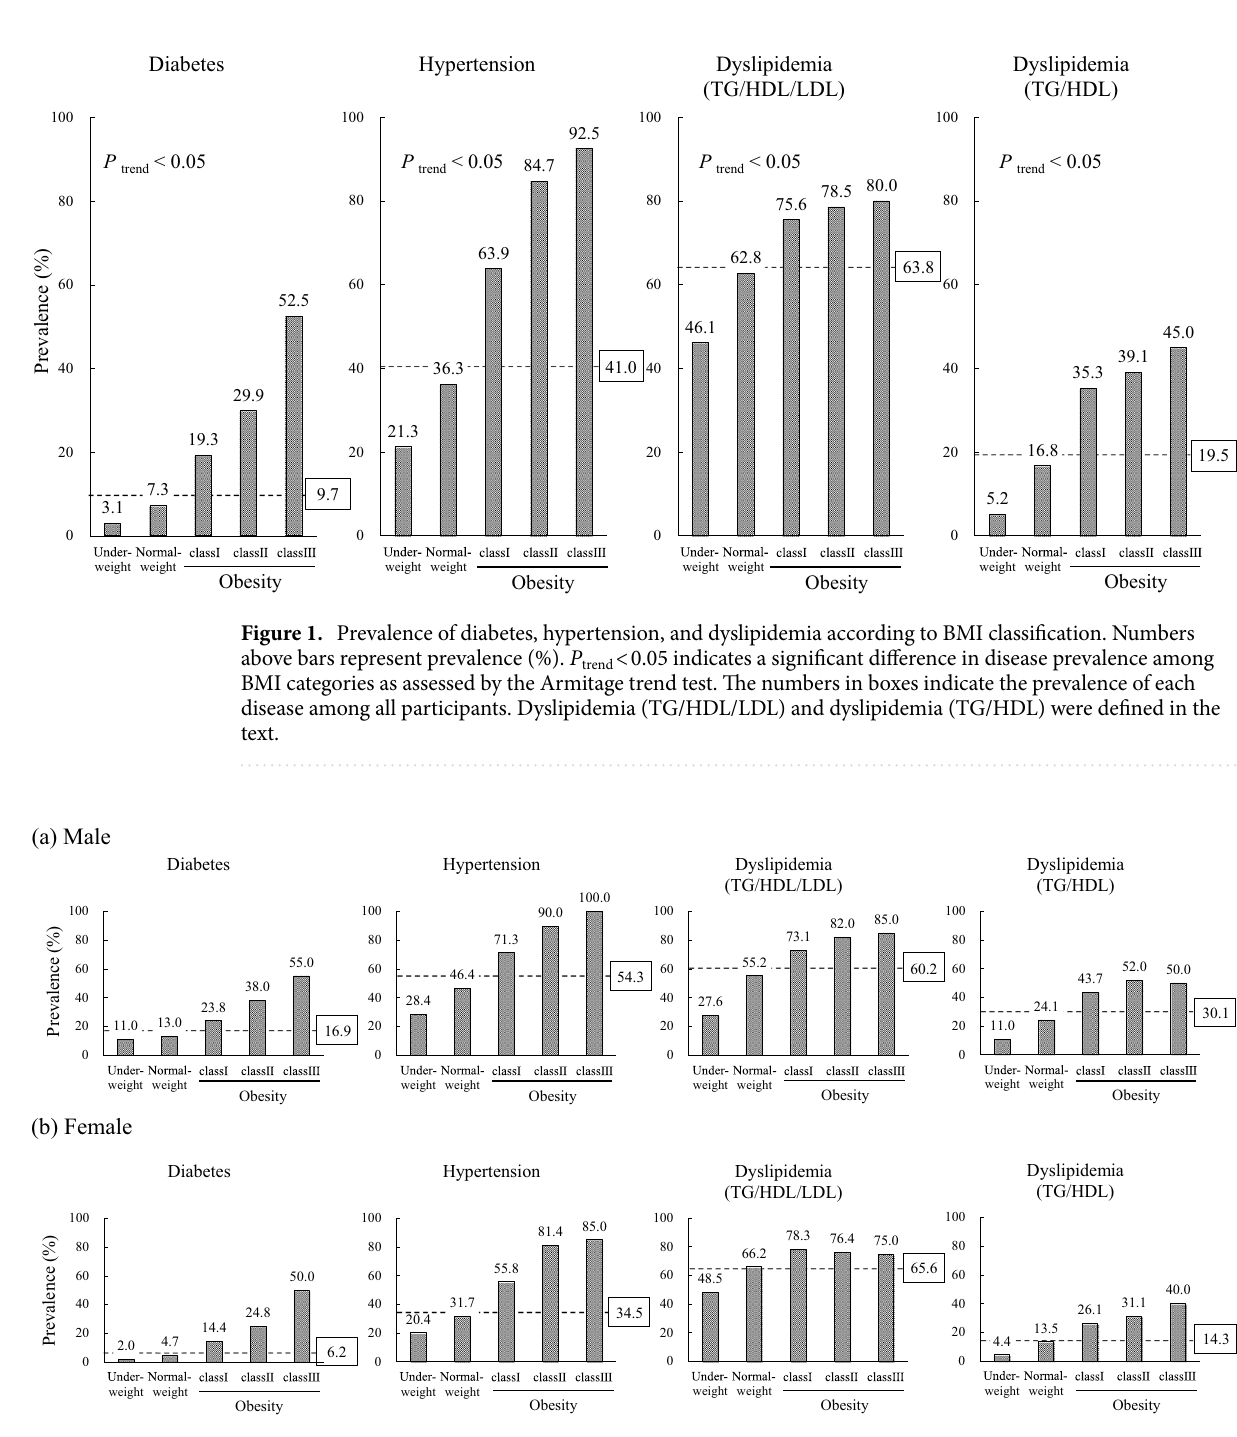
Figure 2. Prevalence of diabetes, hypertension, and dyslipidemia according to BMI classification by gender. Numbers above bars represent prevalence (%). All analyses showed a significant difference in disease prevalence among BMI categories as assessed by the Armitage trend test. The numbers in boxes indicate the prevalence of each disease among each sex of participants. Dyslipidemia (TG/HDL/LDL) and dyslipidemia (TG/HDL) were defined in the